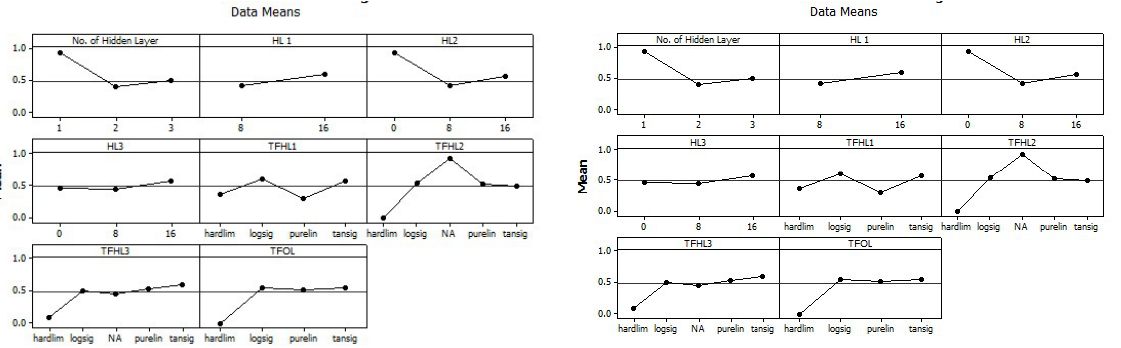
Fig. 2. Main Effects Plot for Validation Performance Fig. 3. Main Effects Plot for Training R